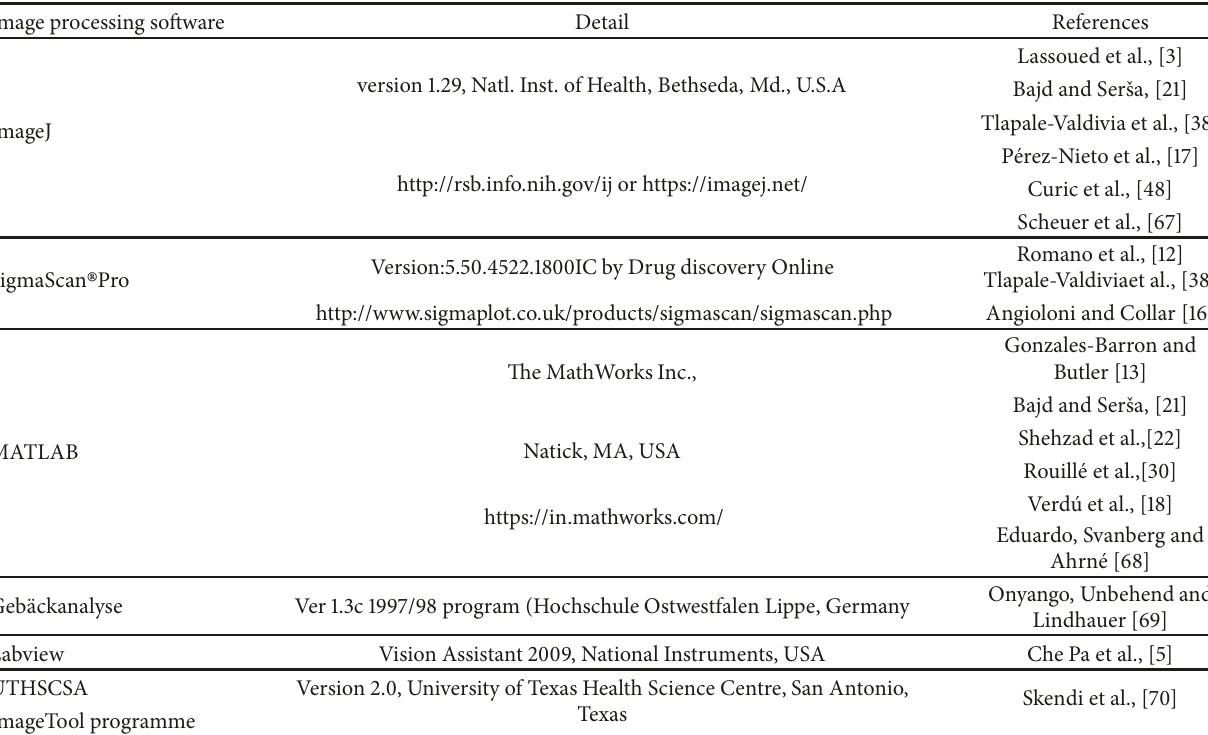
Figure 3: Original (2D) Gray Image (a) and segmented (b) gas cells where black pixels represent bubbles and white pixels represent the porous structure [18]. Table 1: List of examples of image processing